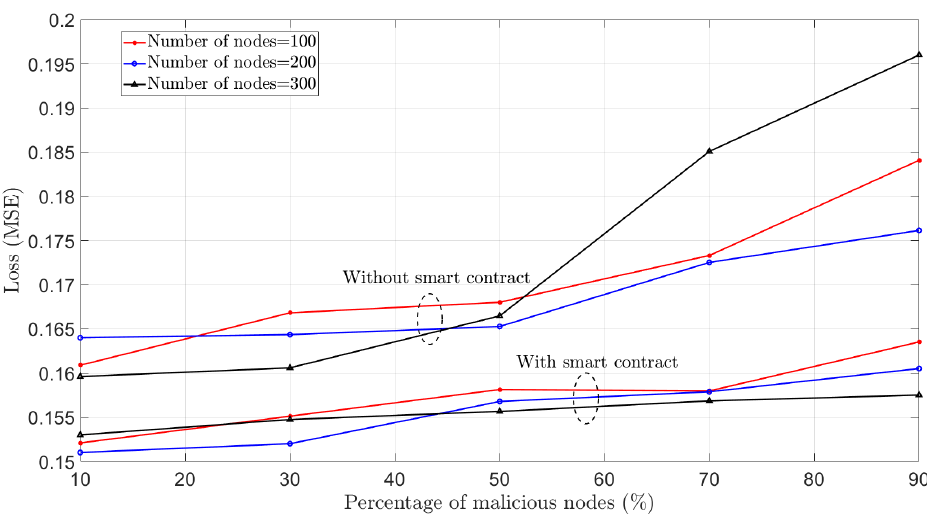
Figure 4. Loss (MSE) of global